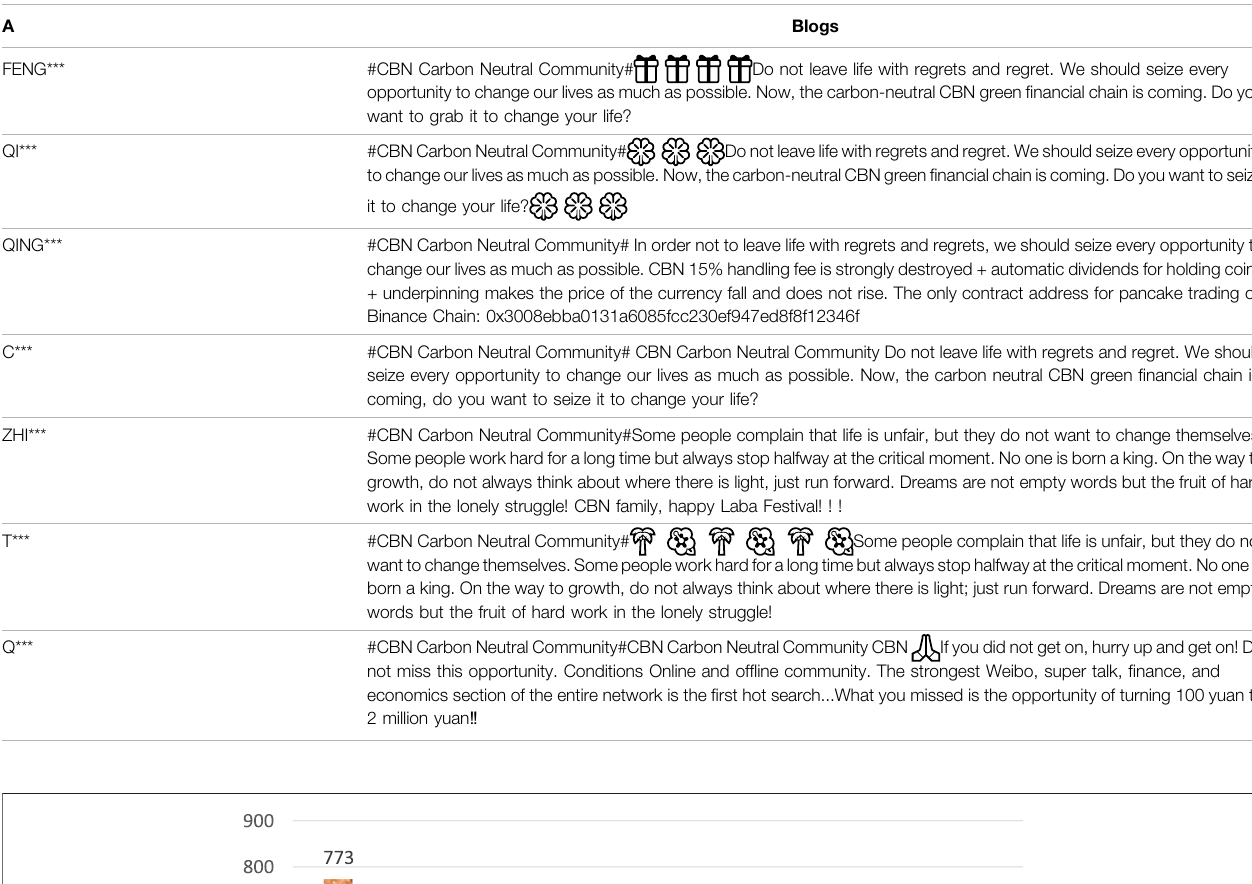
TABLE 3 | Some of the “ CBN ”